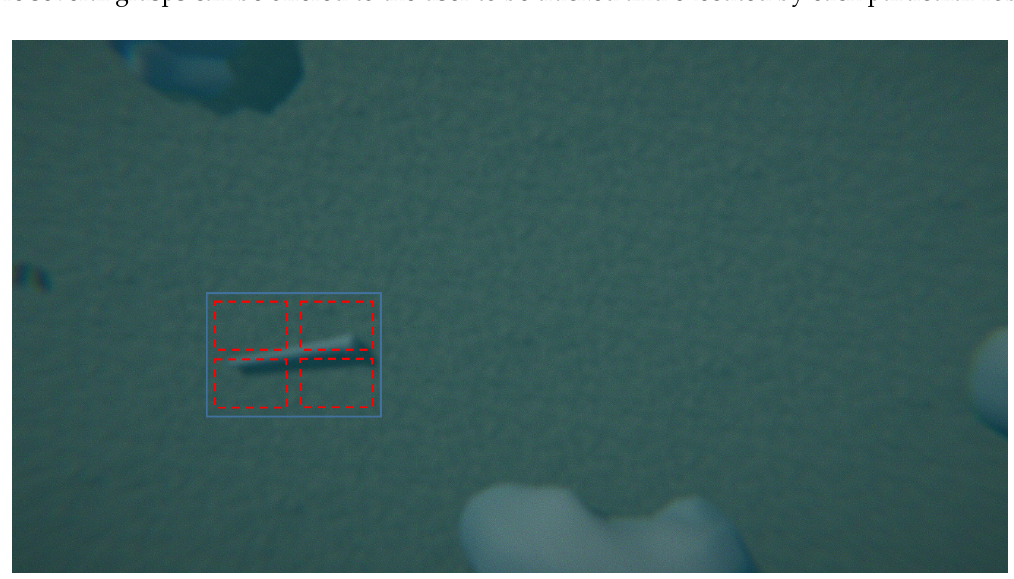
Figure 21. Vision phase 1: object identification (automatic or provided by the